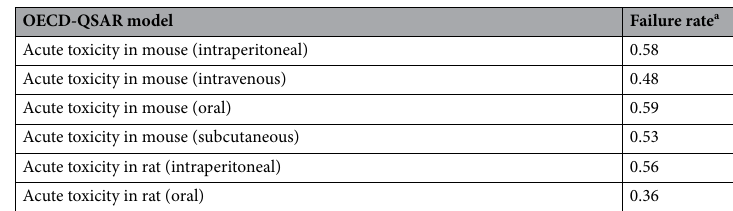
Table 2. Acute toxicity QSAR models for human health hazards and toxicity prediction of CWAs. CWA data of CNN models was used for the prediction. Every CWA should be inserted through query search in IUCLID databased implemented in the OECD QSAR Toolbox. a The failure rate was % ratio of the counted ‘no value’ in each predictive model. No value was produced with ‘out-of-domain’, ‘not applicable’, and none mentioned reason.